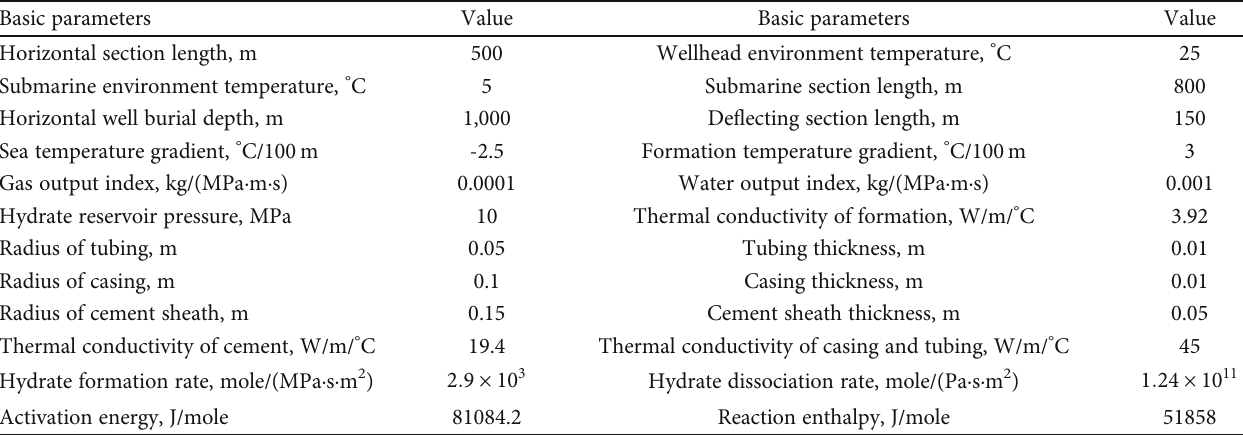
Table 2: Basic parameters.